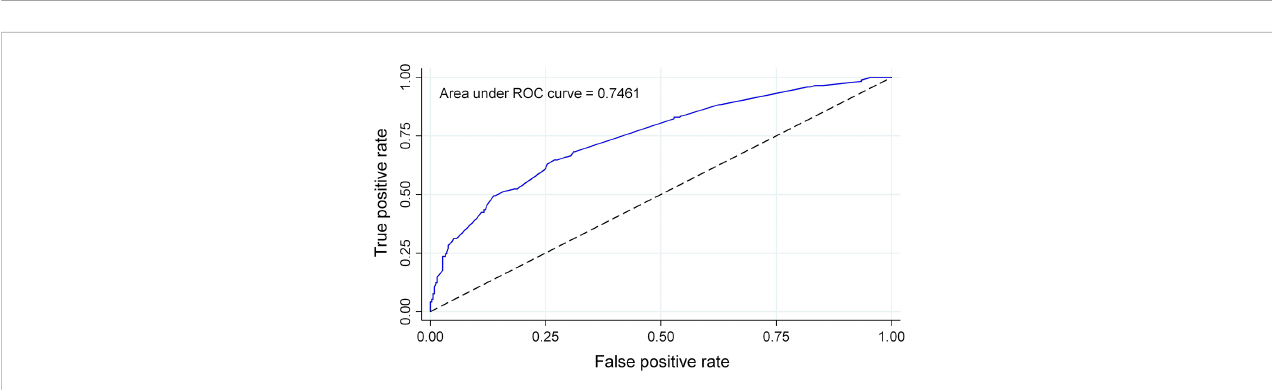
FIGURE 5 AUC for the AITD prediction nomogram. The probability of correctly predicting whether a patient has AITD in selected random cases is indicated by the AUC of a prediction model. The model has strong predictive power, and the overall sample AUC value is